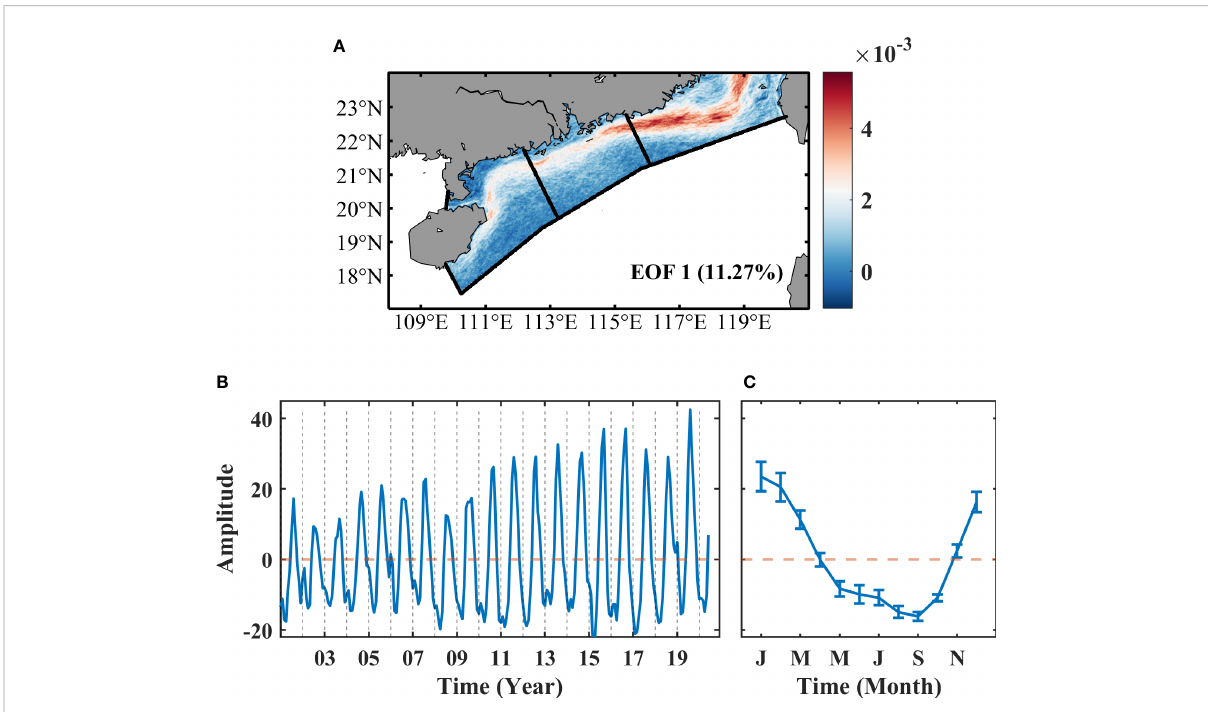
FIGURE 10 The fi rst EOF mode (A) , its corresponding time series for FP (B) , and the mean monthly amplitudes averaged over the 20-yr period (C)